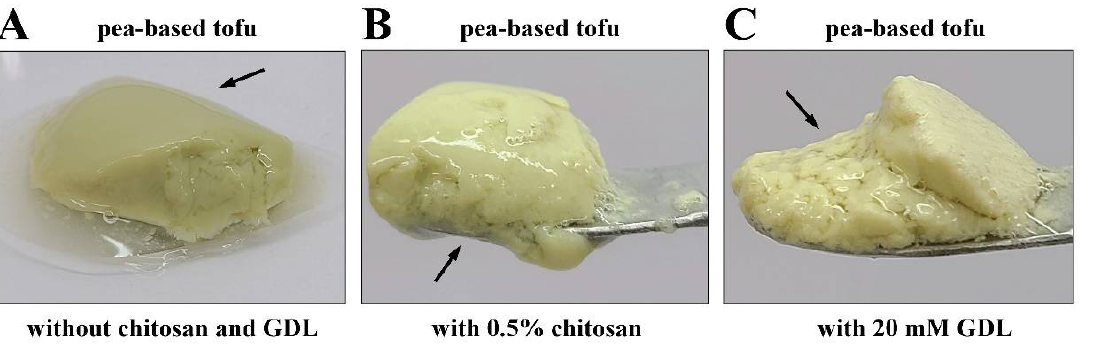
Figure 1. Appearance of pea-based tofu with and without chitosan or GDL: ( A ) without chitosan or GDL, ( B ) with 0.5% chitosan, and ( C ) with 20 mM GDL.